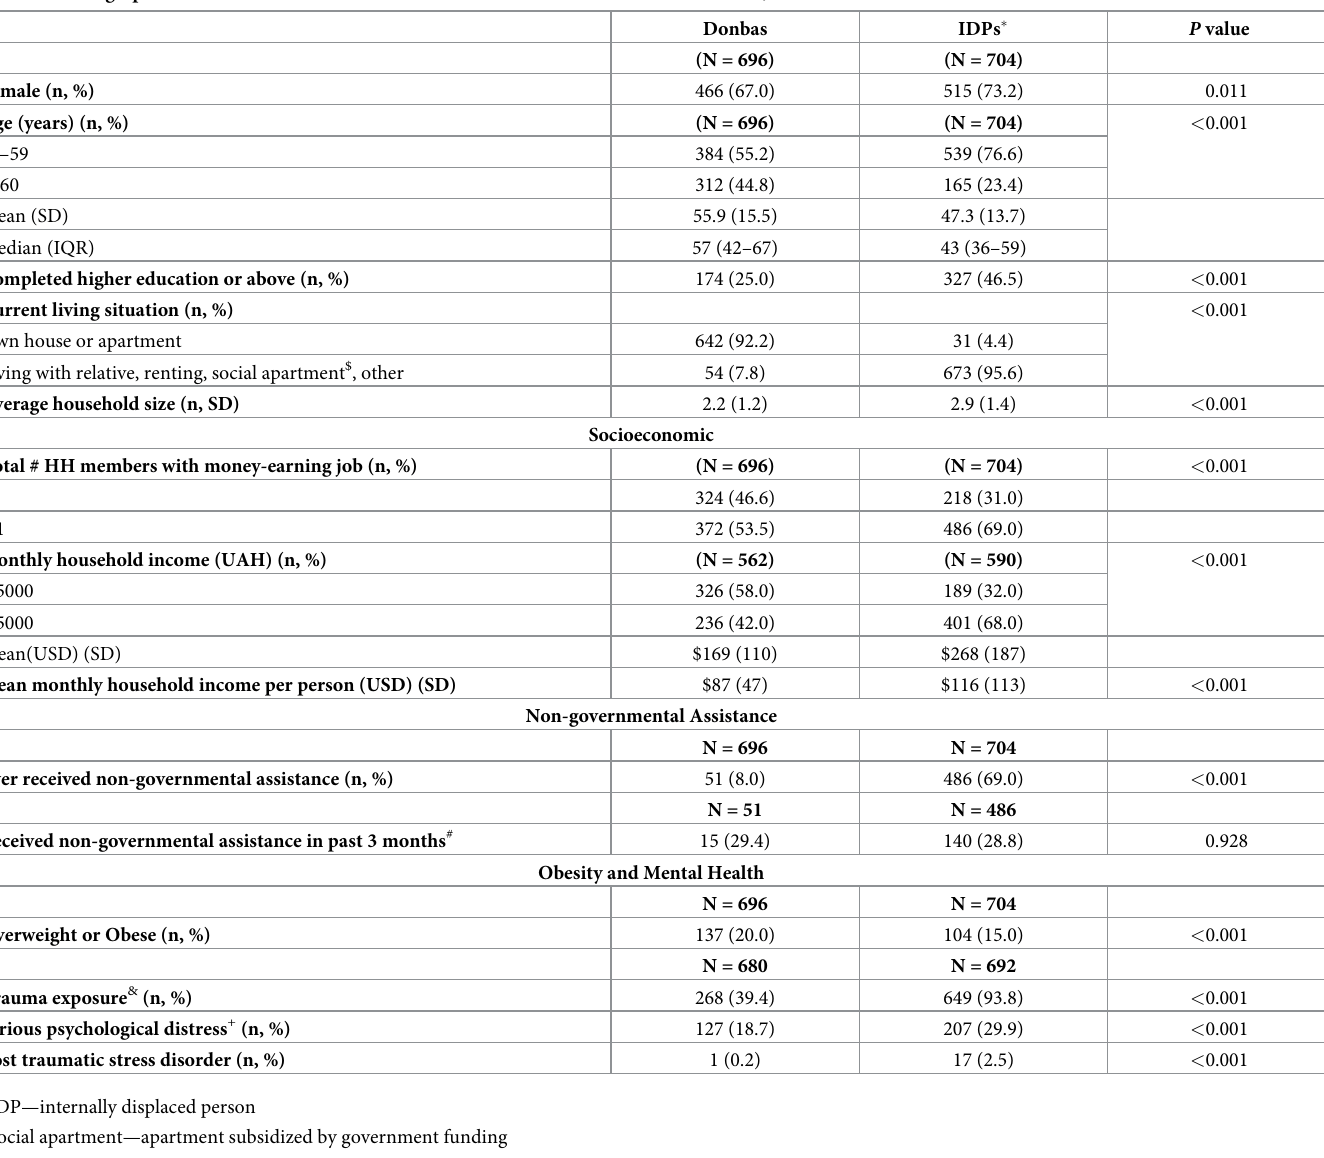
Table 1. Demographic and socioeconomic characteristics of conflict-affected adults in Ukraine,